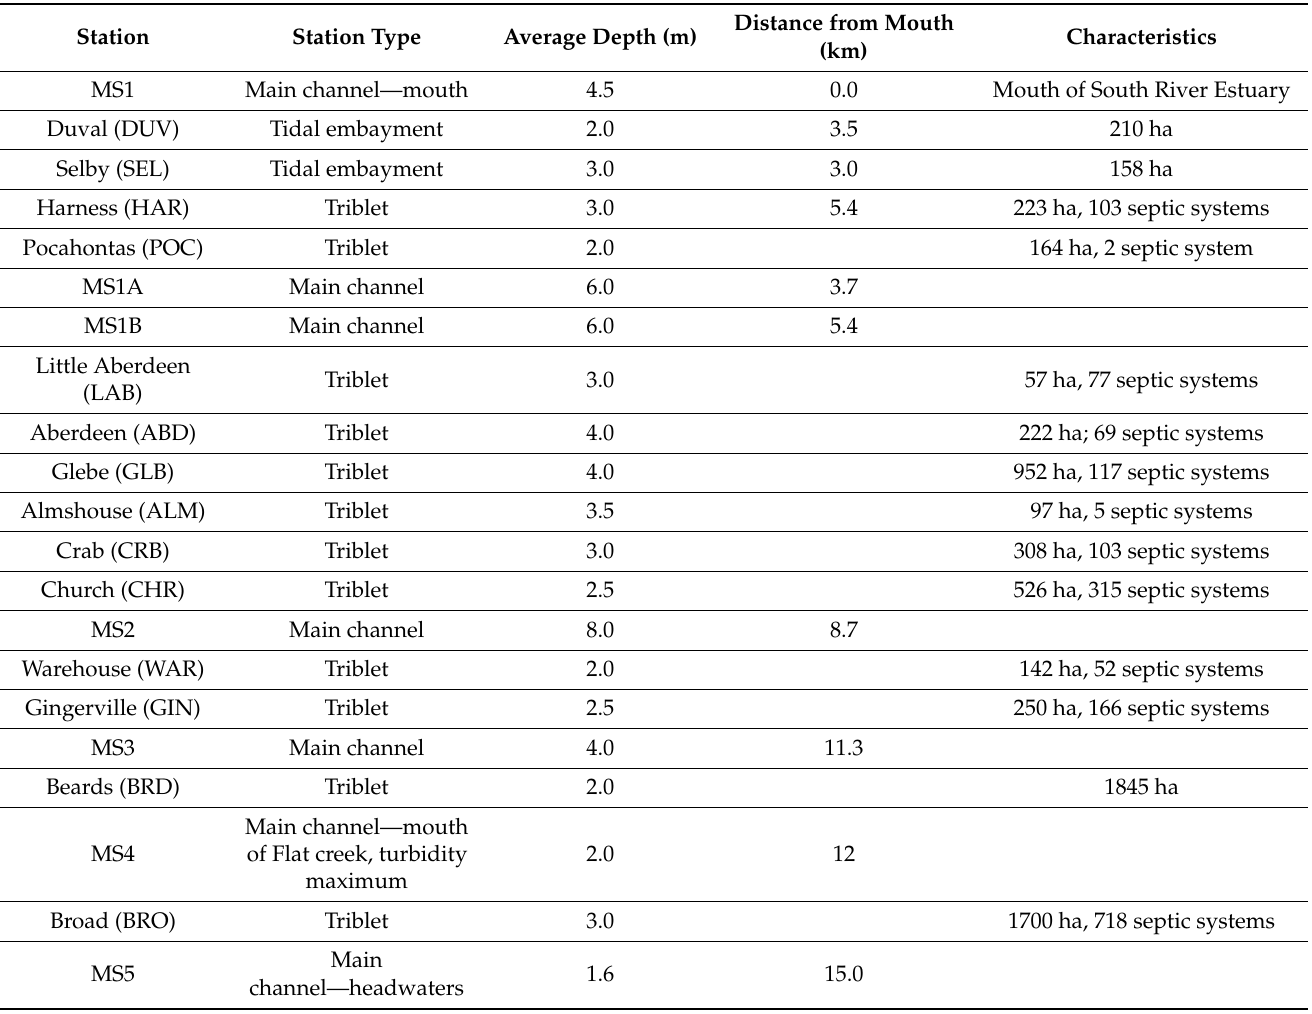
Table 2. Research site detailed descriptions, including land-use for